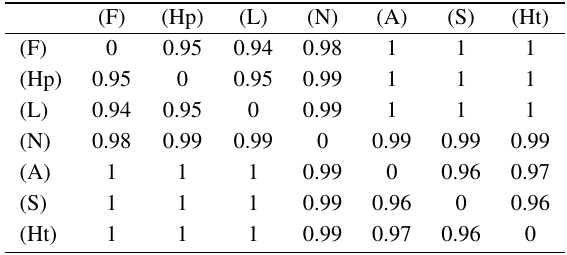
Table 10 Distance between the different sentiments as measured with D P